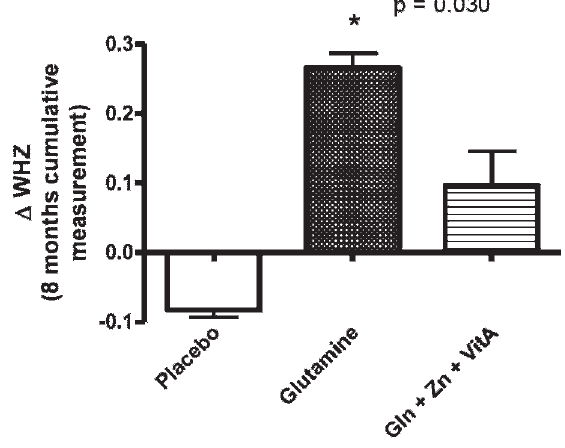
Figure 2 - Cumulative weight-for-height z-score (WHZ) with adjustment for age and season over eight months follow-up in Brazilian shantytown children from Fortaleza, northeastern, Brazil, treated with placebo, glutamine (Gln), and glutamine plus zinc (Zn) and vitamin A